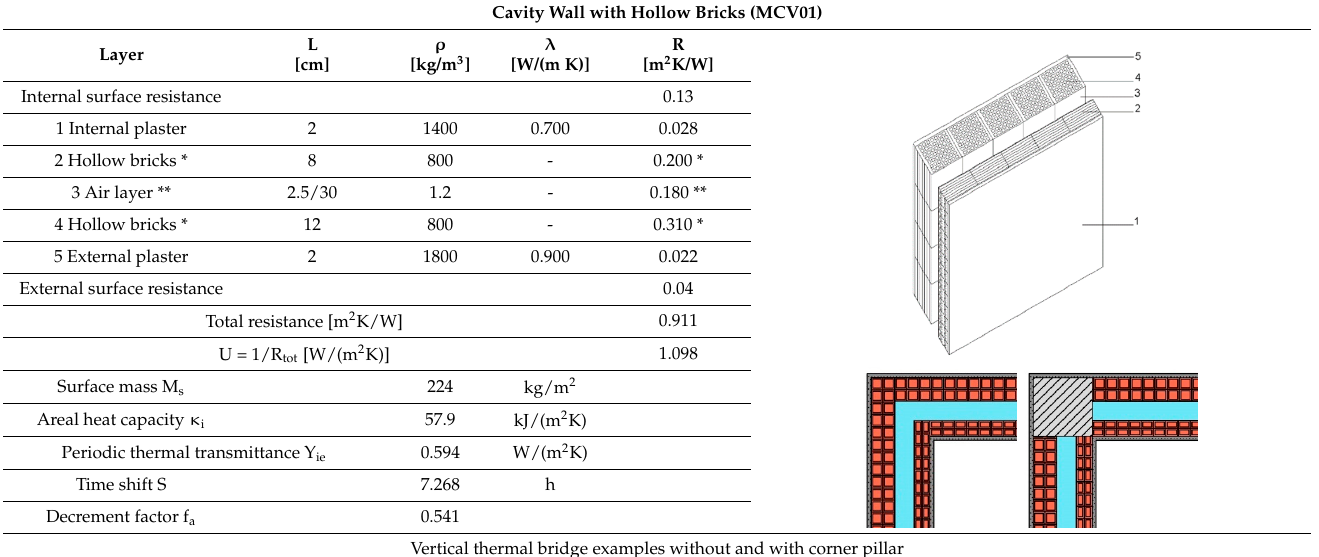
Table 6. Main features of the case study.